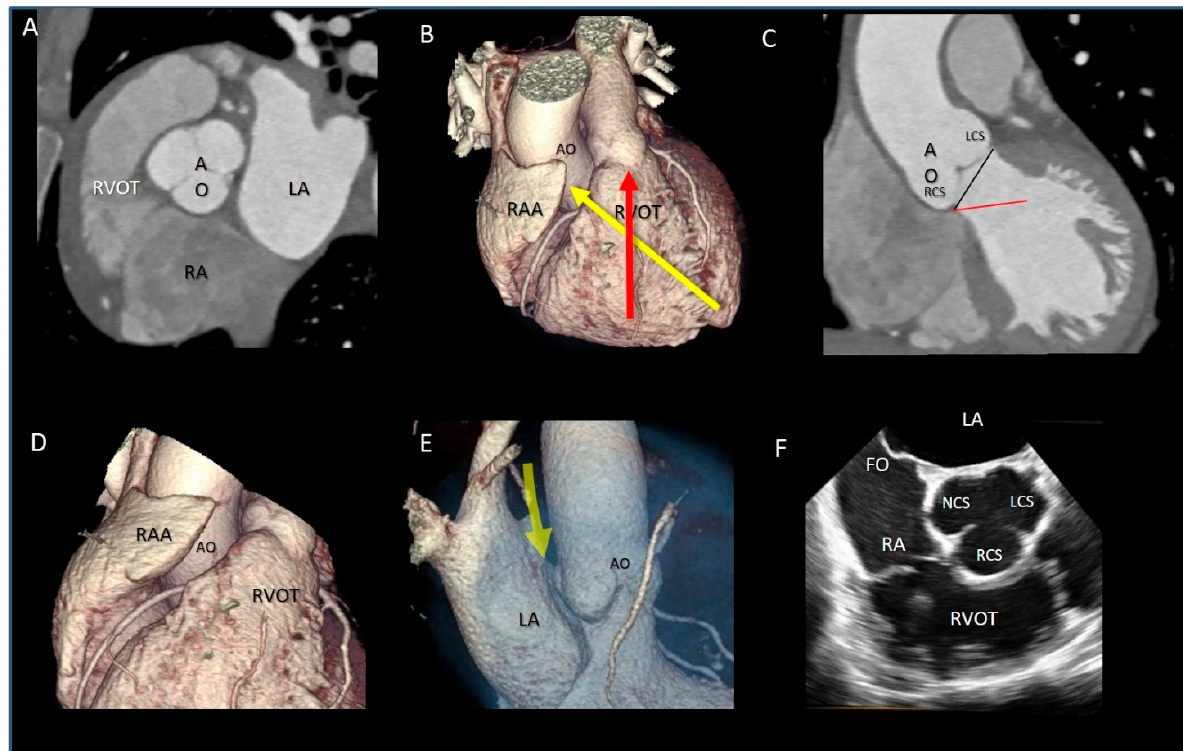
Figure 1. ( A ) Computed tomographic image in multiplanar modality, showing the aortic root (AO) is the cardiac centerpiece, surrounded by the atria and the right ventricular outflow tract (RVOT). ( B ) The 3D volume rendering CT image in antero- posterior projection showing the obliquity of the aortic root (yellow arrow), sited posterior and rightward to the RVOT (red arrow). ( C ) Computed tomographic in multiplanar imaging modality showing the correct attitudinal orientation of the aorta. The black line, that joins the nadir of aortic sinuses, is near 30 ◦ tilted in respect to the horizontal red line, so that the left coronary sinus (LCS) and its leaflet are at the highest position among the right coronary (RCS) and non-coronary sinuses. ( D ) CT image in 3D volume rendering modality in antero-lateral projection showing the AO is surrounded laterally by the right atrial appendage (RAA). ( E ) CT image in 3D volume rendering modality in lateral projection, showing the space between the left atrium (LA) and the AO (yellow arrow) named “sinus transversum” filled up by epicardial adipose tissue. ( F ) The 2D transesophageal echocardiography in short-axis aortic view, showing the close proximity between the fossa ovalis (FO) and the non-coronary sinus (NCS) (see